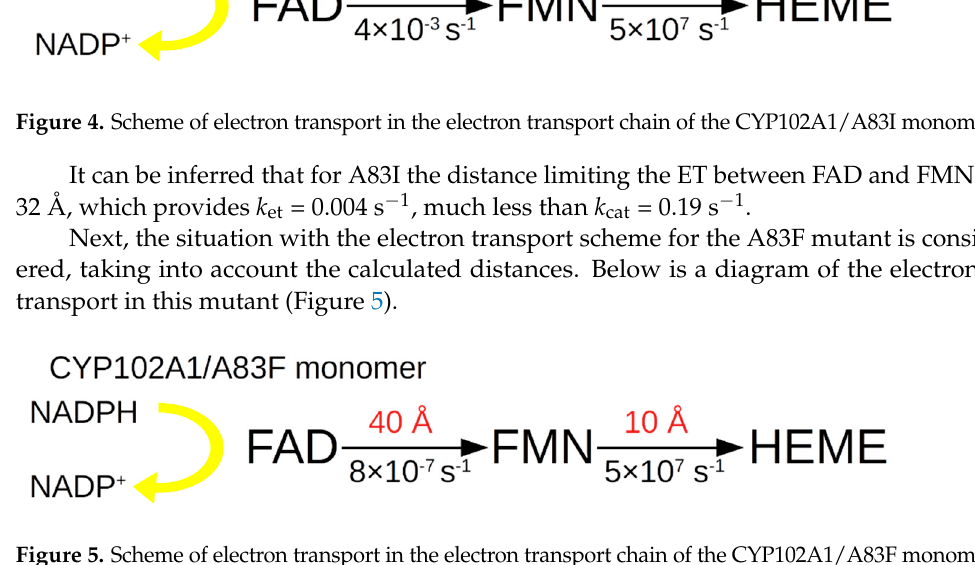
Figure 3. Alignment of monomer CYP102A1/WT predicted in AF2 to monomer from homodimer calculated using AFMultimer. The colours indicate the monomer domains: heme domain (orange), FMN domain (red), FAD domain (cyan). The surface denotes the second monomer of the homodi- mer, where light blue is heme domain 2, pale yellow is FMN-domain 2, light pink is FAD-domain